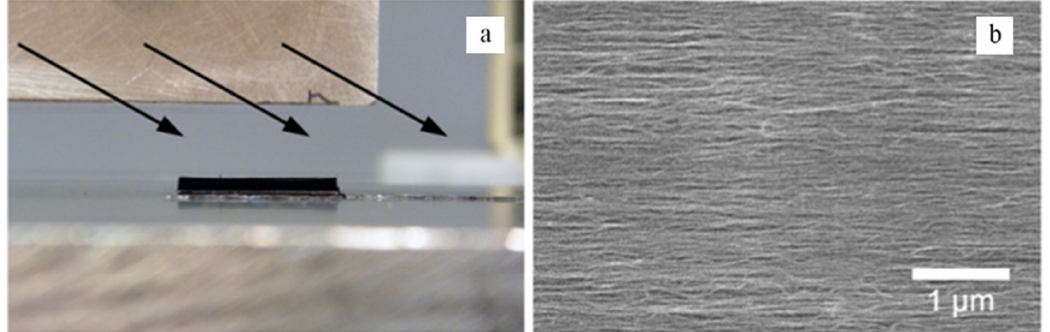
Figure 5. Illustration of the superacid slide casting method. Reproduced with permission [61]. Copyright 2013, Royal Society of Chemistry.